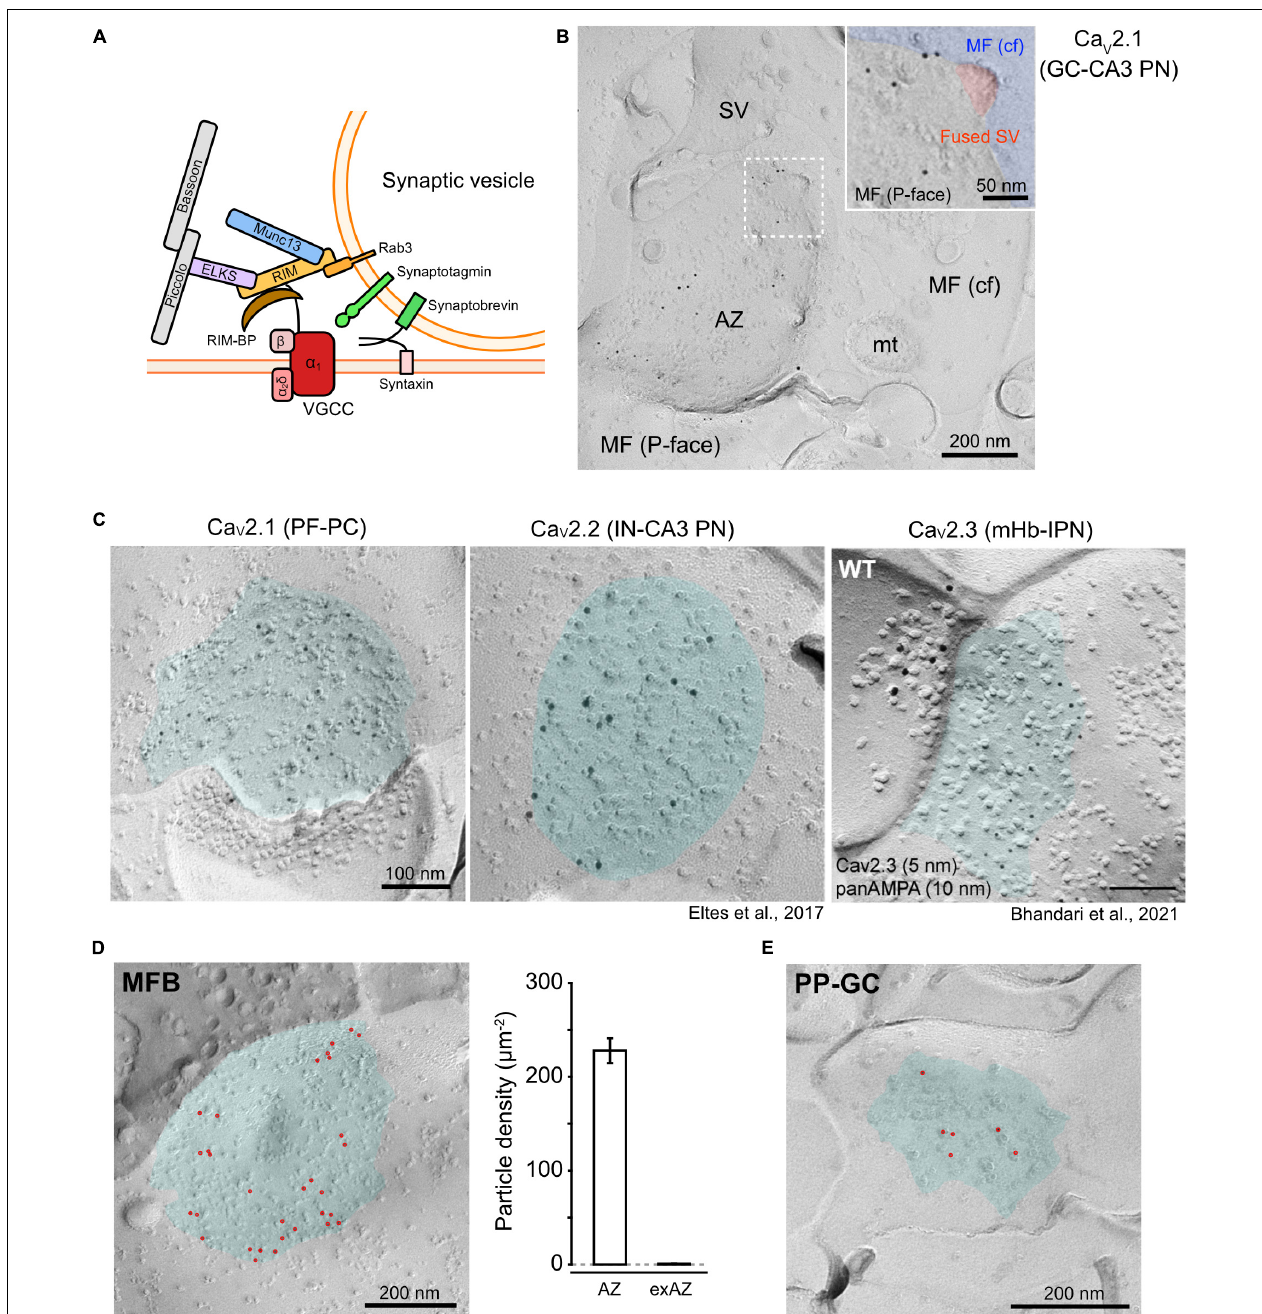
FIGURE 1 | Distribution of Ca V 2 channels at the presynaptic AZs. (A) A schema of a Ca V 2 channel assembled with presynaptic proteins related to SV fusion. (B) An example EM image of Ca V 2.1 particles concentrated in an AZ of a rat hippocampal dentate gyrus granule cell (GC)-CA3 pyramidal neuron (PN) synapse. Inset is a high-magnified image of the square area (dashed line) showing Ca V 2.1 particles around a fused SV (indicated with red). (C) Distribution of Ca V 2 subtypes in AZs of different synapse types. Left , labeling for Ca V 2.1 at a PF-PC synapse in the mouse cerebellum. Middle , labeling for Ca V 2.2 at an IN-CA3 PN synapse in the mouse hippocampus (Éltes et al., 2017). Right , labeling for Ca V 2.3 (5 nm) and AMPA-type glutamate receptor (panAMPA, 15 nm) at an mHb-IPN synapse in the mouse brain (Bhandari et al., 2021). Cyan indicates AZ areas. (D) Left , Ca V 2.1 labeling at the AZ in an MFB of P28 Wistar rat. Red points indicate gold particles. Right , a bar graph showing the density of Ca V 2.1 particles in the AZs and non-AZ areas (non-AZs) of the rat MFBs. (E) Ca V 2.1 labeling in a perforant path-GC synapse obtained from the same replica preparation as panel (D) . MF, mossy fiber; AZ, active zone; SV, synaptic vesicle; cf, cross-fracture; mt, mitochondria; PF, parallel fiber; PC, Purkinje cell; IN, interneuron; mHb, medial habenula; IPN, interpeduncular nucleus; MFB, MF bouton.